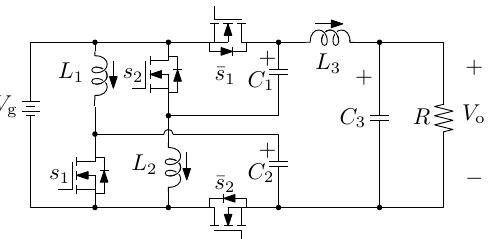
Figure 3. Proposed high step-up power converter, named the “Double Dual Super Boost